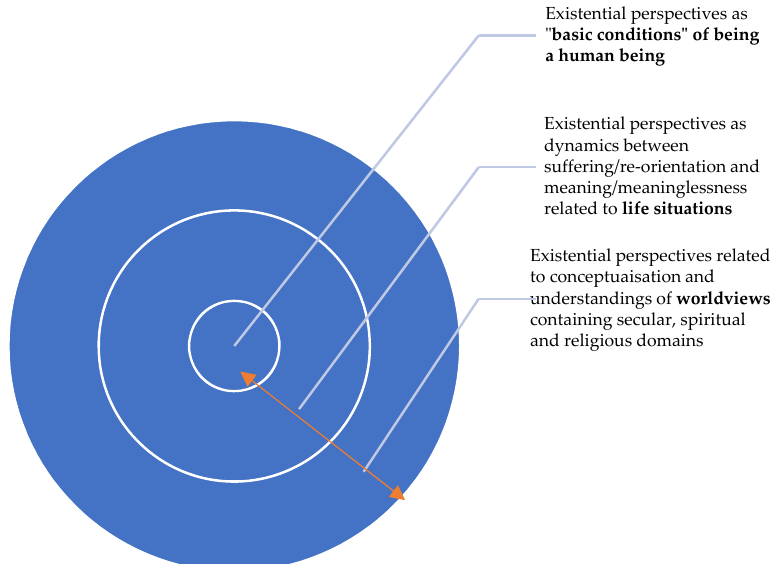
Figure 5. A definition of ‘existential’ in the framework of healthcare.